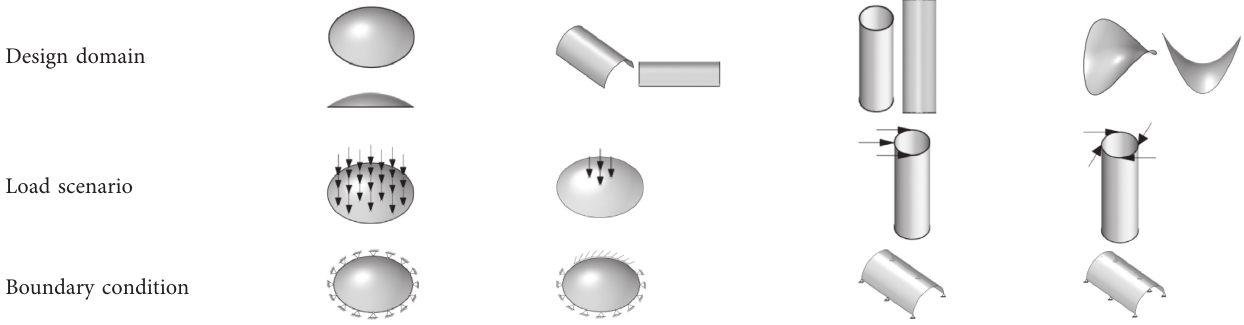
Table 5: Parameters for shells.